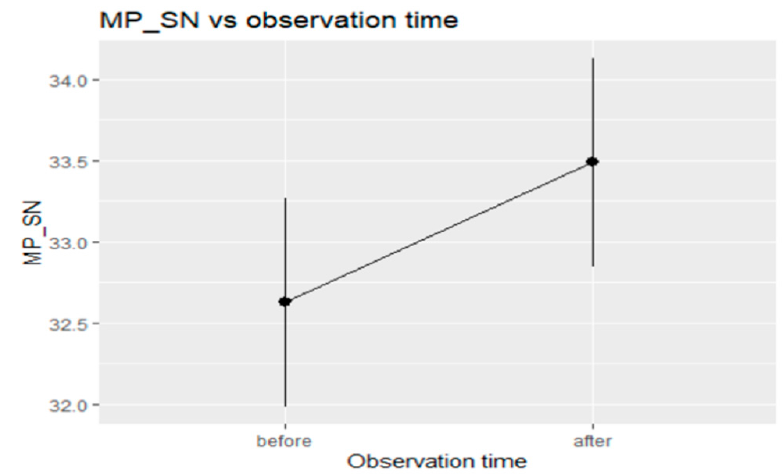
Figure 8. Trend in Wits appraisal over time from T0 to T1.